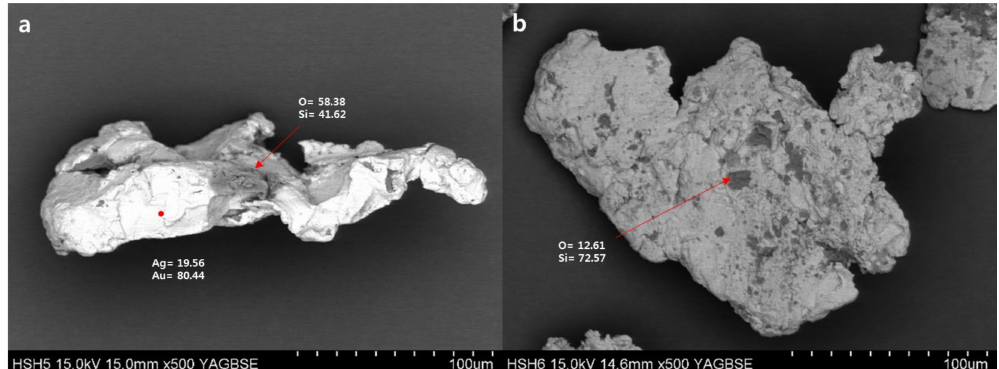
Figure 10. SEM-BSE image and SEM-EDS of native gold grains and gangue minerals from hydro-separation. Red dots and arrows are EDS spot positions. The heavy minerals (( a – c ); nitric acid 4.0–6.0 M, respectively).